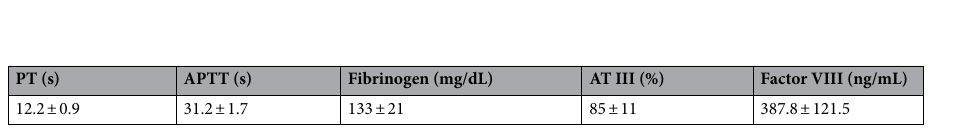
Table 1. Properties of hemoglobin vesicles. Data are expressed as the value or range. *p50, arterial blood oxygen tension at which hemoglobin is half saturated with oxygen. HbVs hemoglobin vesicles.